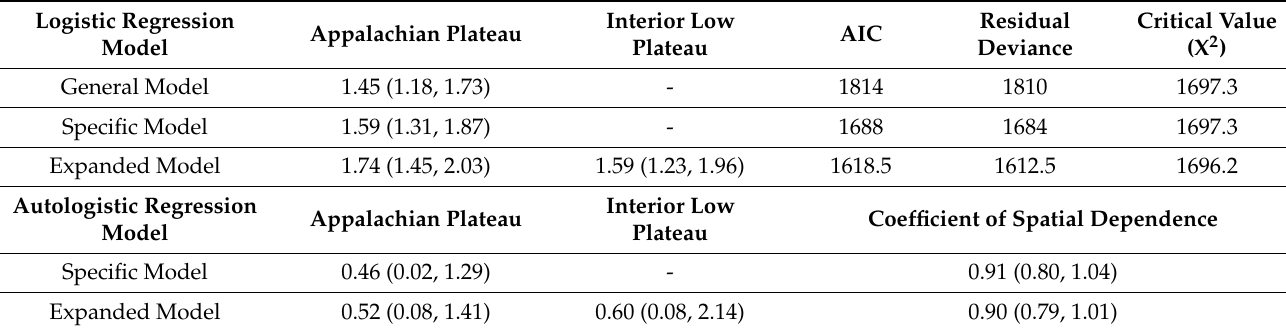
Table 2. Coefficients for logistic regression models for reported hemorrhagic disease activity in the eastern United States during 2017. The coefficients and confidence intervals for the logistic regression models on top. The coefficients and confidence intervals for the fitted centered autologistic “specific” and “expanded” models at the bottom. Confidence intervals are given in parentheses. The deviance test showed that while the specific and expanded models both adequately fit the data, the general model showed a significant lack of fit. The model with the lowest Akaike information criterion (AIC) value represents the model with the best